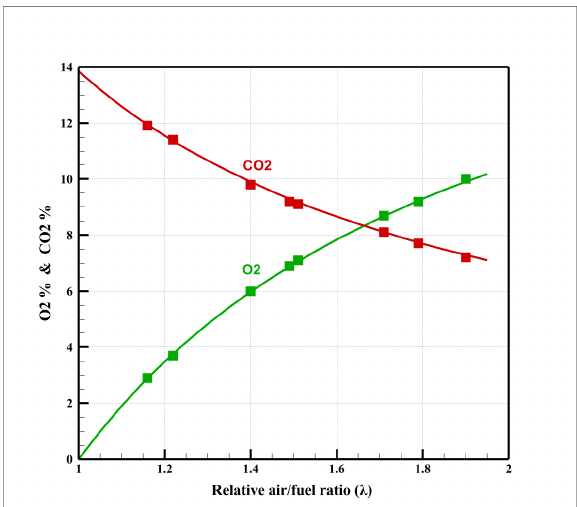
Fig. 8. Variation of O 2 and CO 2 versus equivalence ratio for propane fuel